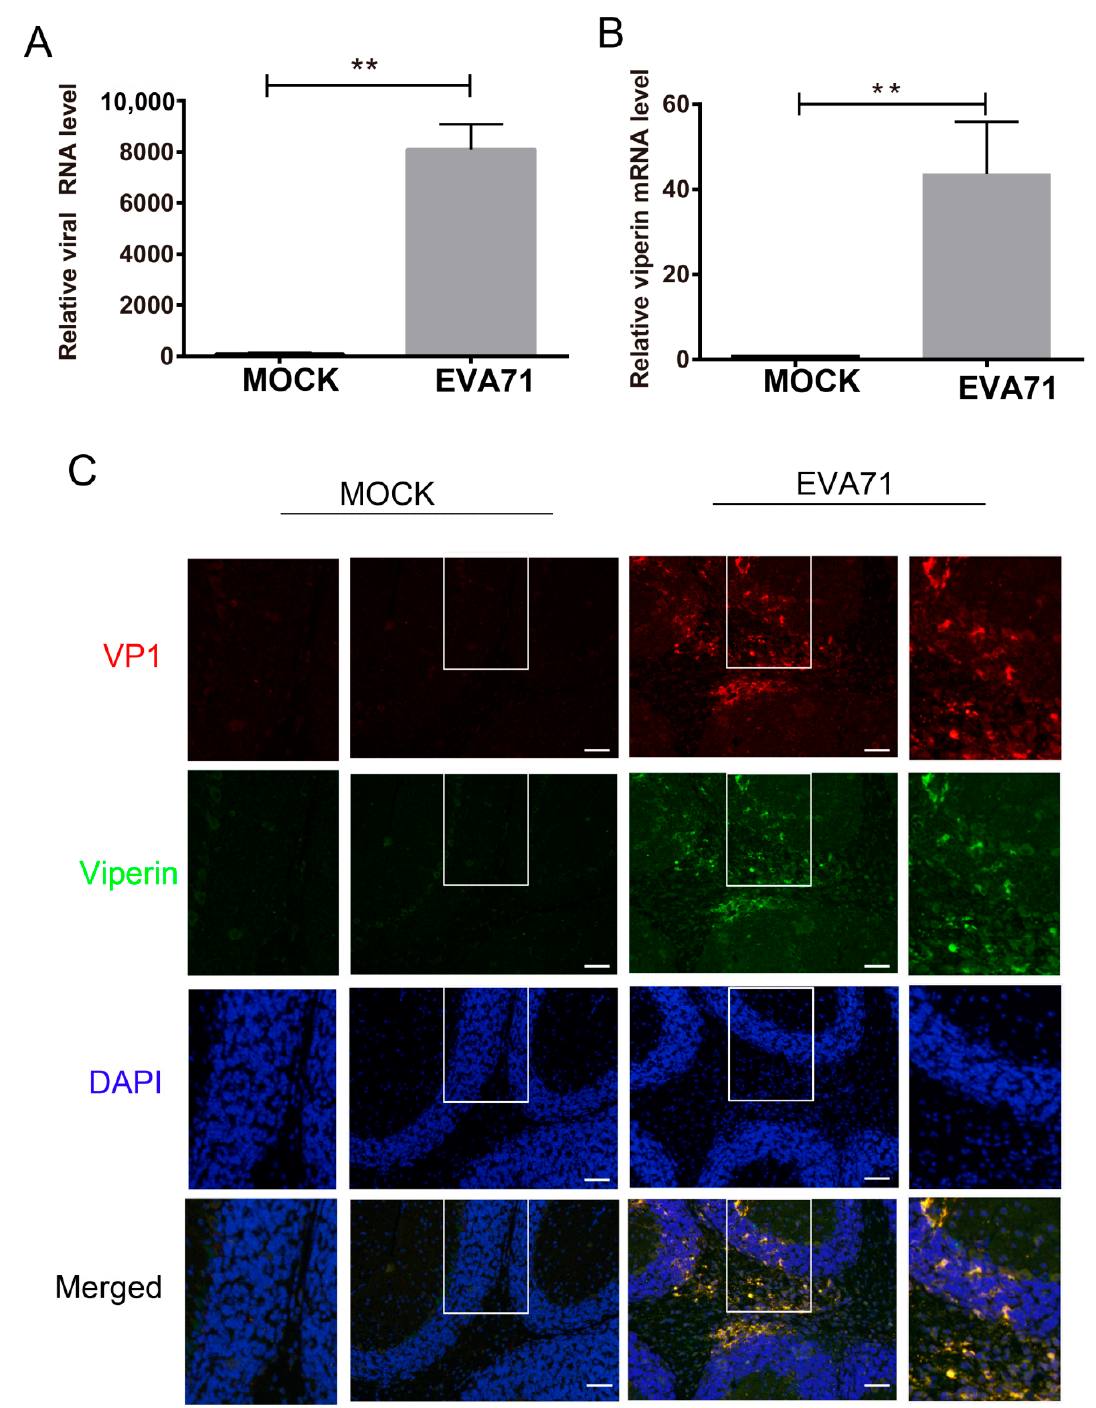
Figure 2. EVA71 induced viperin expression in vivo. Two-week-old BALB/c mice were infected with high-virulence EVA71 (GZ-CII strain), and the relative expression levels of ( A ) viperin and ( B ) EVA71 viral RNA in brain tissues were measured using q-PCR with GAPDH as a control. Data are representative of at least three independent experiments performed in triplicate (mean ± SD of fold change). * p < 0.05 and ** p < 0.01. ( C ) Double-labeling immunohistochemistry analysis of EVA71 VP1 and viperin in the brain tissue was performed. Green fluorescence represents viperin protein, red fluorescence represents EVA71 VP1 protein, and blue fluorescence represents nuclei. The scale bar in the images is 20 µm. The enlarged images corresponding to the rectangle areas are shown next to the original image.